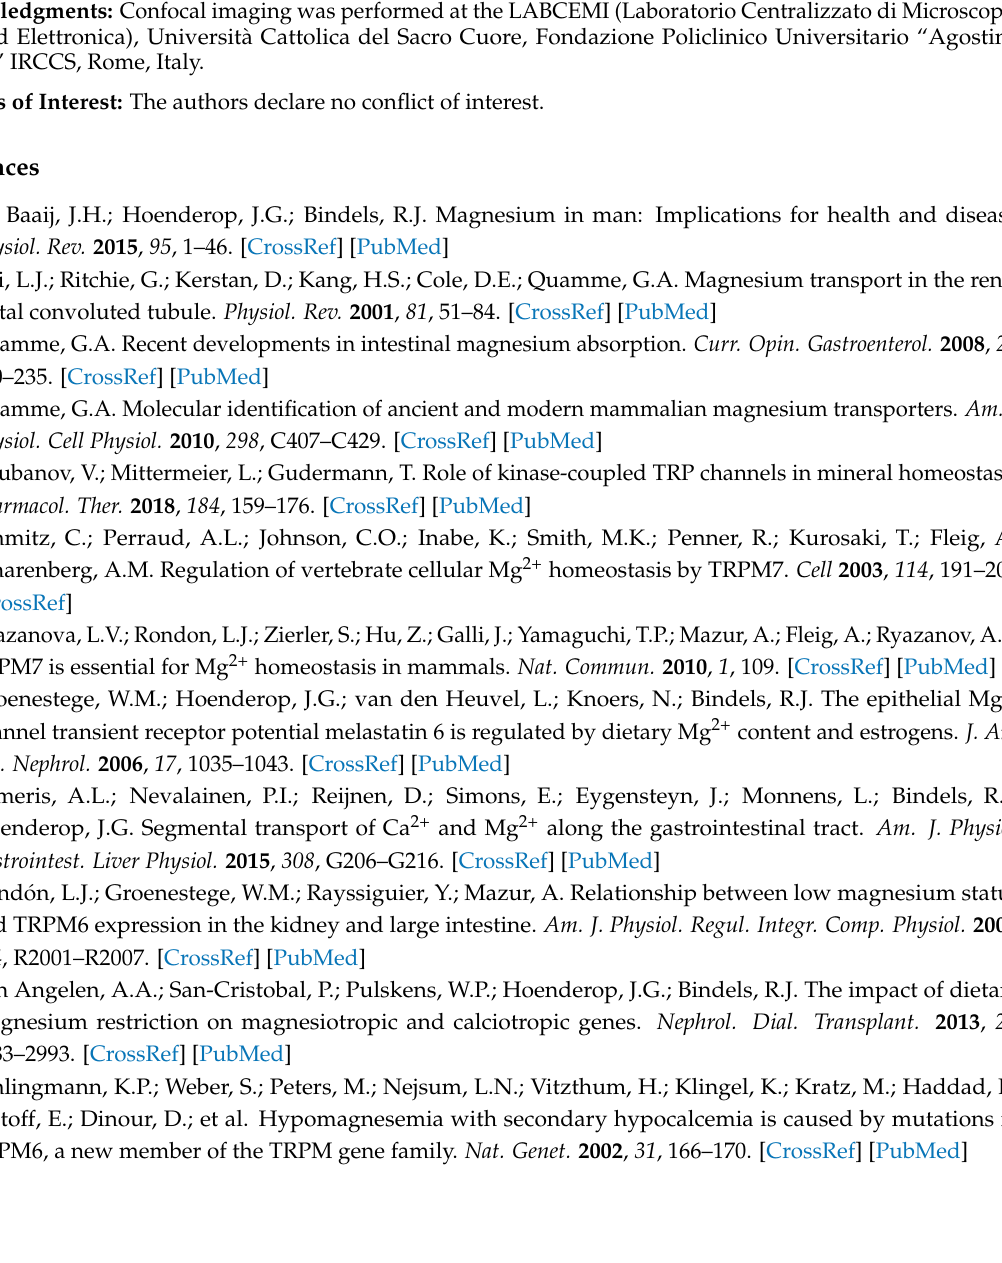
Figure S1: Complete blots corresponding to the images shown in Figure 2A. Figure S2: Transient siRNA transfection efficiently downregulates TRPM7 mRNA in human HT29 and HCT116 colon cells ( A ), and TRPM7 protein in HCT116 cells ( B ). Figure S3: Contribution of TRPM7 to Mg 2+ influx and Mg-dependent cell functions in HCT116 cells. ( A ) Mn 2+ quenching; ( B ) Mg 2+ influx capacity; ( C ) Cell Proliferation; ( D ) Cell cycle